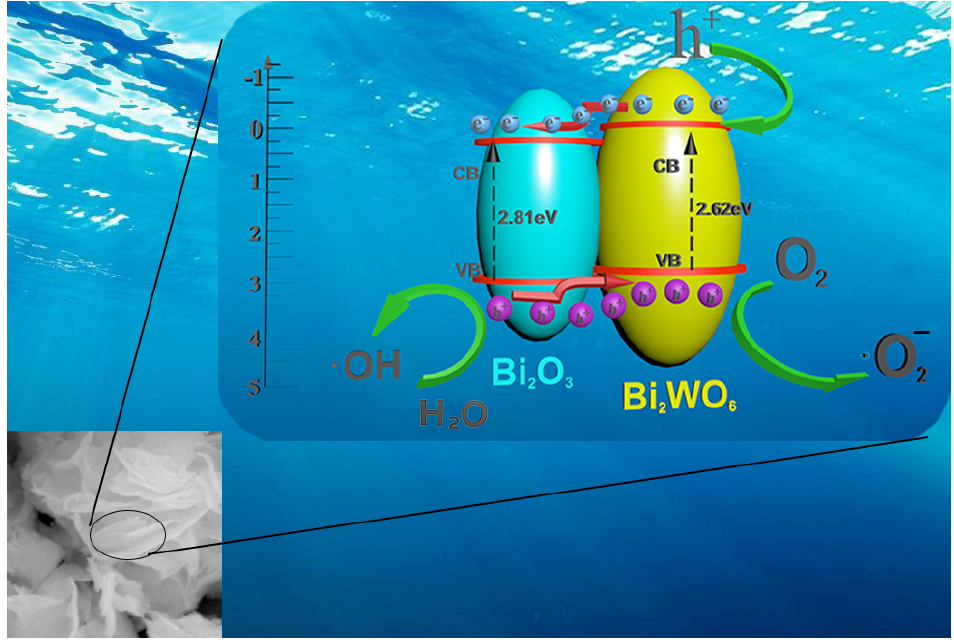
Figure 10. The 3D schematic diagram of the heterojunction structure and photocatalytic mechanism of the Bi 2 WO 6 @Bi 2 O 3 heterojunction composite catalyst.